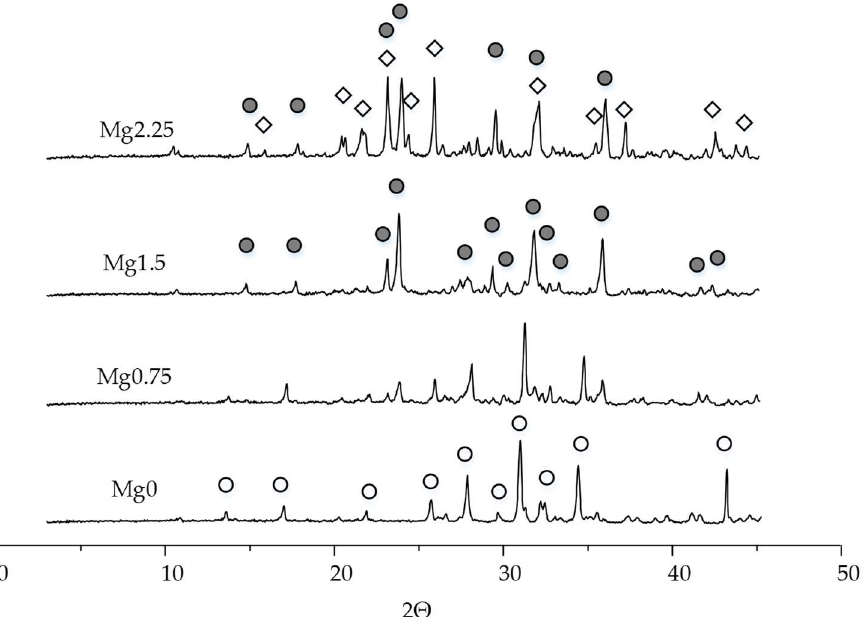
Figure 1. X-ray diffraction pattern of Mg x Ca 3−x (PO 4 ) 2 powders for Mg0, Mg0.75, Mg1.5, Mg2.25, where is tricalcium phosphate Ca 3 (PO 4 ) 2 (TCP); is magnesium calcium phosphate Mg 3 Ca 3 (PO 4 ) 4 ; and is trimagnesium phosphate Mg 3 (PO 4 ) 2 .